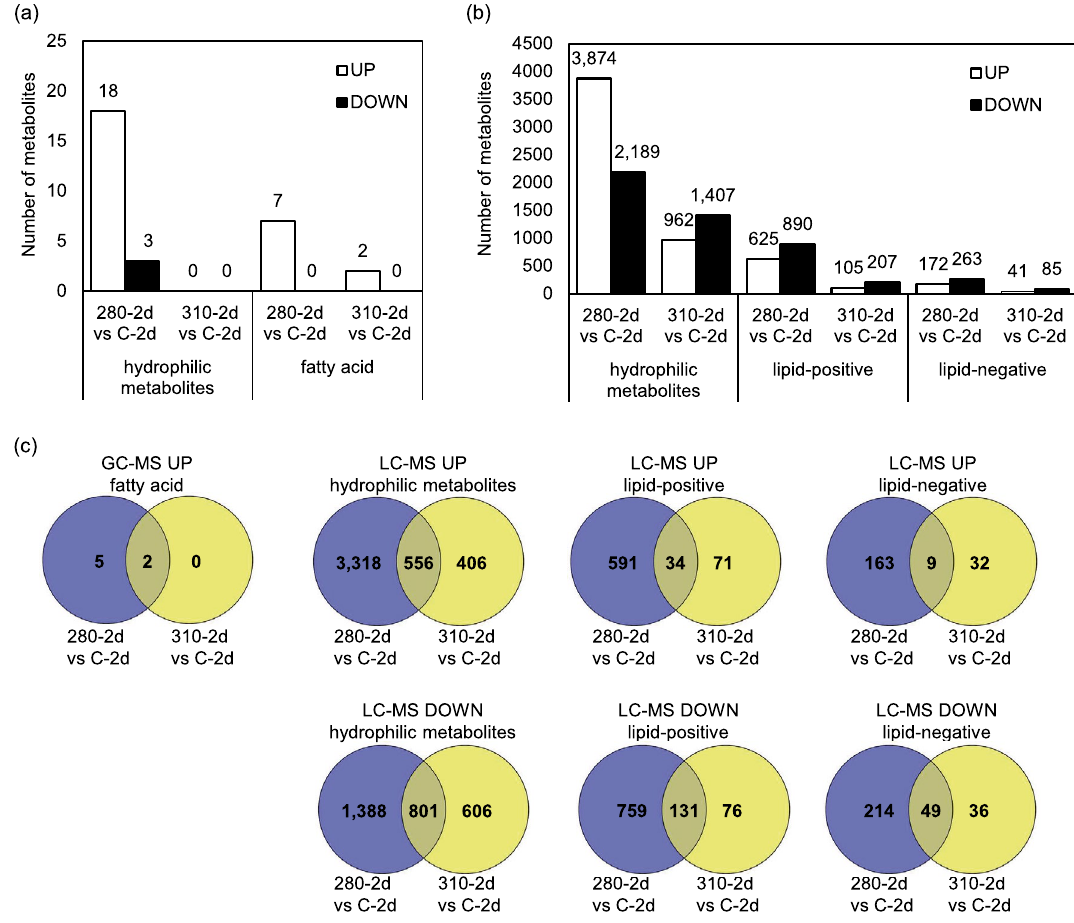
Figure 2. Overall description of metabolome data. ( a ) Comparison of increased and decreased numbers of metabolites under 280 and 310 nm UV annotated by GC–MS. Welch’s t -test was applied for comparison of UV-irradiated samples with control, and a metabolite with a P -value less than 0.05 was considered significantly changed. ( b ) Comparison of increased and decreased numbers of metabolites under 280 and 310 nm UV annotated by LC–MS. Welch’s t -test was applied for comparison of UV-irradiated samples with control, and metabolite with a P -value less than 0.05 was considered significantly changed. lipid-positive, lipids annotated in the positive ion mode; lipid-negative, lipids annotated in the negative ion mode. ( c ) Venn diagrams illustrating the shared and unique increased and decreased metabolites between samples under 280 and 310 nm